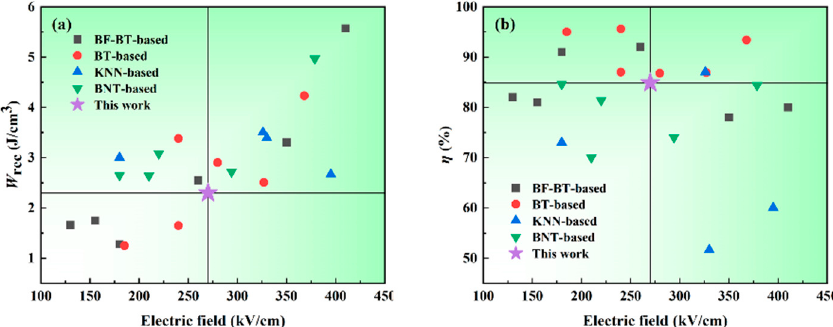
Figure 8. A comparison of ( a ) W rec and ( b ) η as a function of electric field in this study and as reported in other lead-free bulk ceramics (BT-BF-based: [22,39–43]; BaTiO3-based: [44–49]; (K0.5Na0.5)NbO3- based: [50–54]; Bi0.5Na0.5TiO3-based: [55–58]).